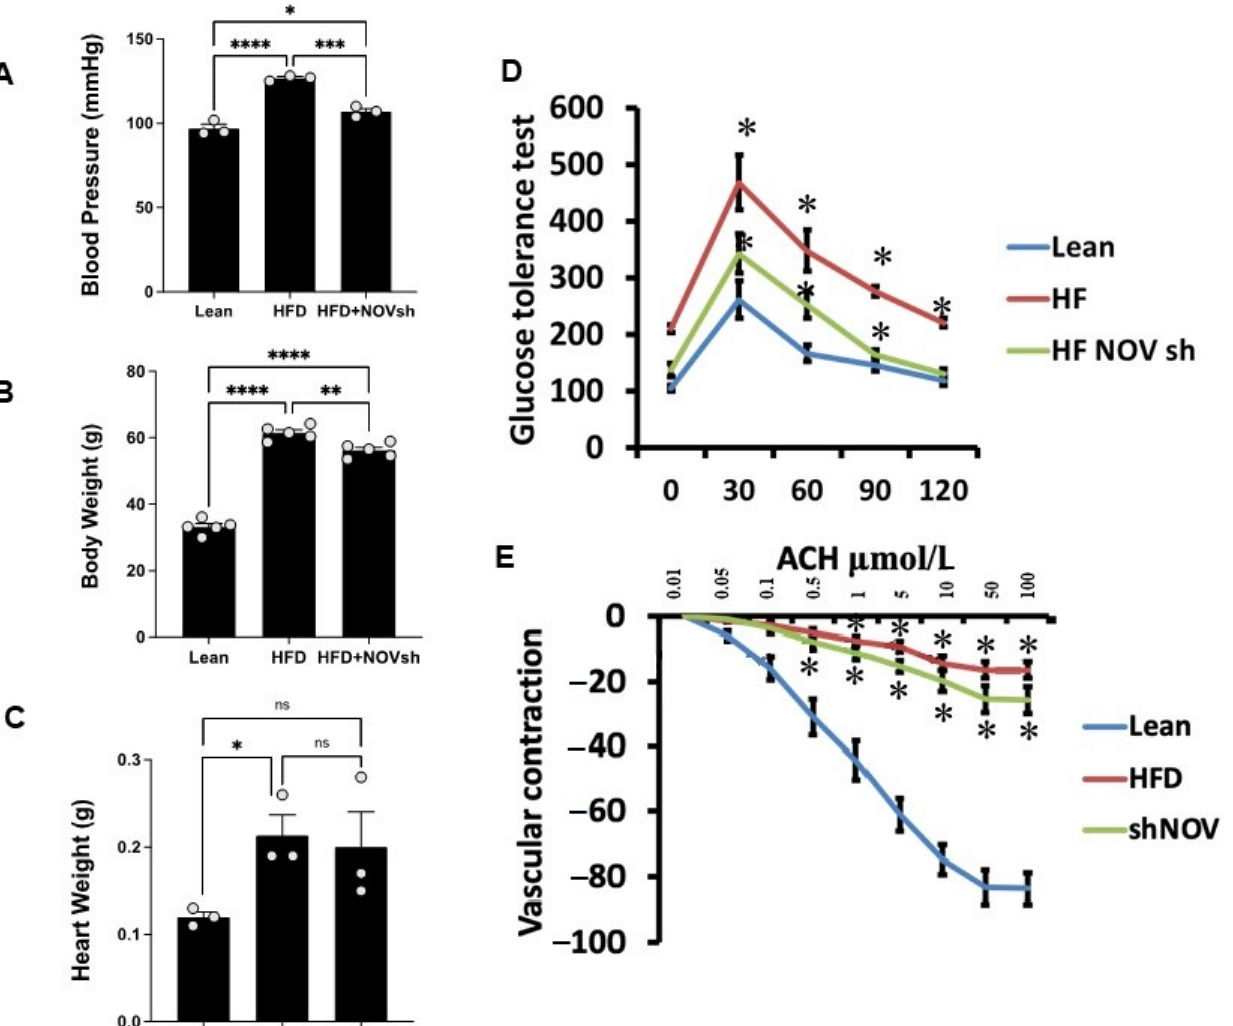
Figure 6. Blood pressure, body weight, heart weight, and glucose tolerance are all improved in shNOV-treated mice (NOV knockdown) on an HFD followed by the activation of PGC-1 α , with an improvement in metabolic syndrome. Blood pressure ( A ), body weight ( B ), heart weight ( C ), glucose tolerance ( D ), and vascular contraction ( E ), of lean, high-fat, and shNOV-treated mice. Results are means ± SE; * p < 0.05, ** p < 0.01, *** p < 0.001, **** p < 0.0001, ns = not significant.